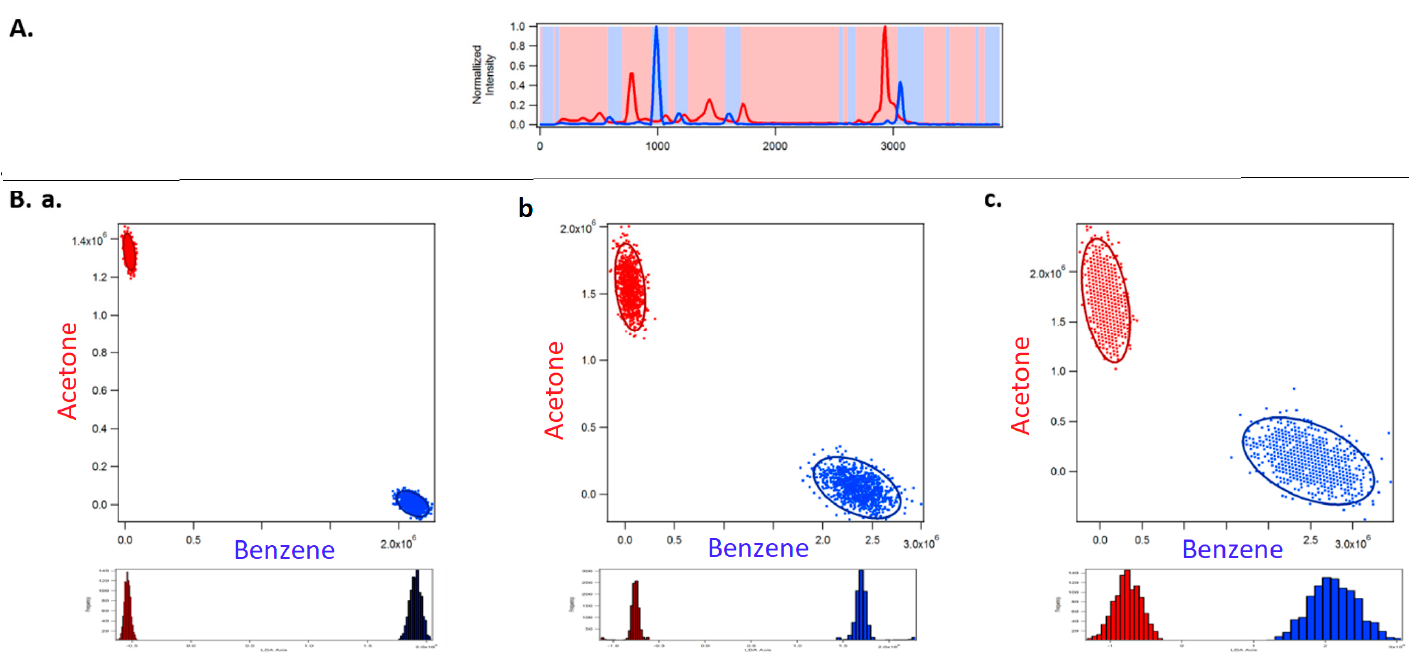
Figure 4. The figure shows the classification of acetone and benzene with OBCD2 filtering (using complementary OBCD filters). Panel ( A ) shows the normalized spectra of acetone (red, top left) and benzene (blue, top right) collected to be used as training spectra to generate OBCD2 filters. This panel also shows OBCD2 filters (shaded red and blue), i.e., the OB wavelengths that are multiplexed onto two PMTs. Sub panels ( a – c ) in Panel ( B ) correspond to 1000 OBCD classification of acetone and benzene in 1 ms using 30 mW, 3 mW, and 1 mW laser power at the sample, respectively.